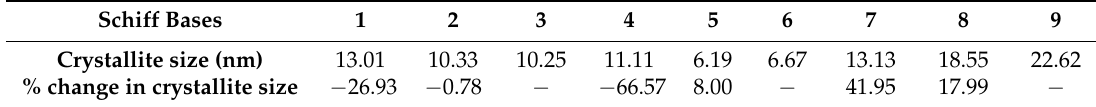
Table 3. Crystallite size (nm) of Schiff base 1 – 9